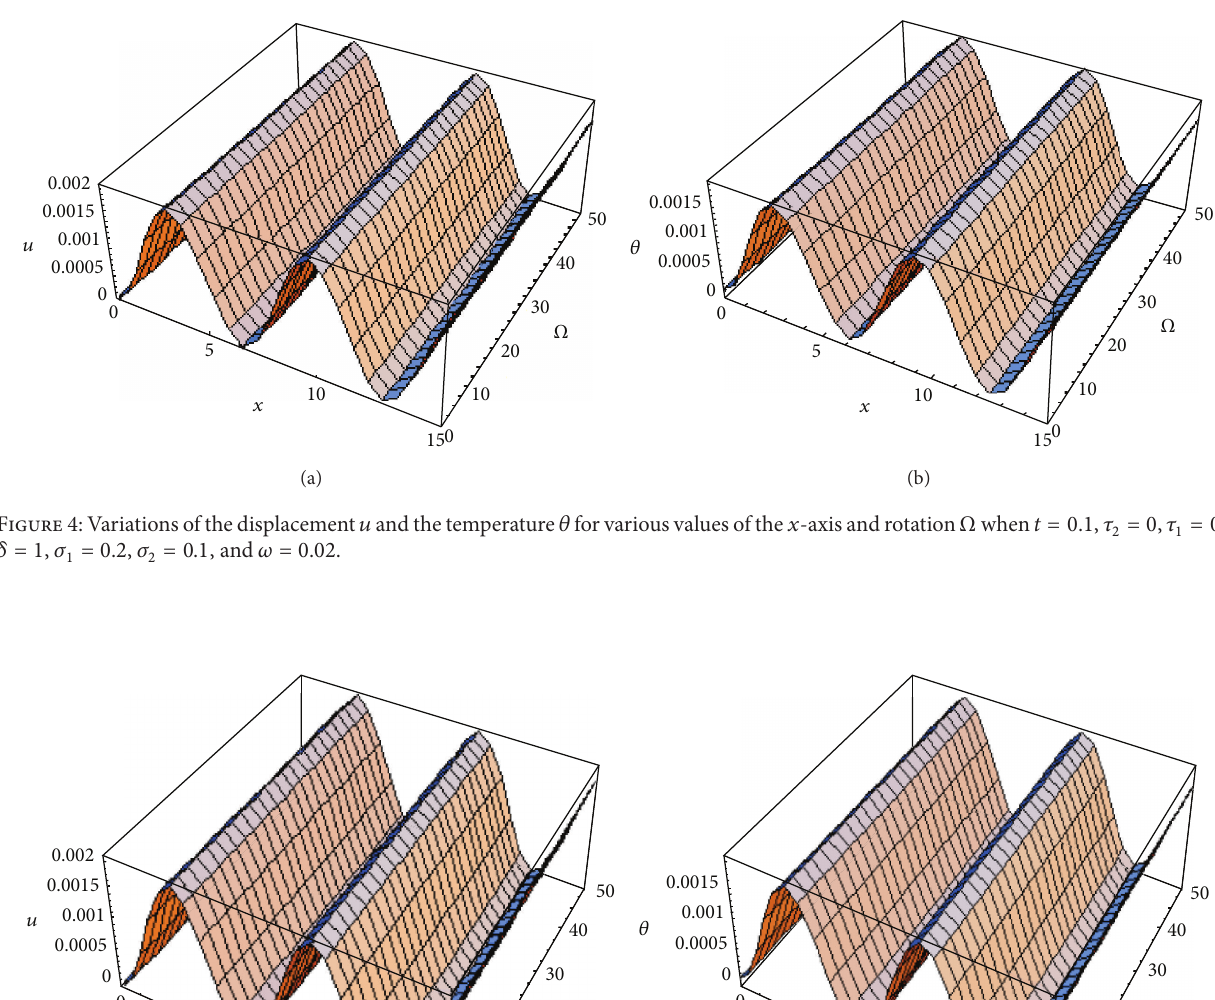
corresponding values in the absence of 𝜎 1 , 𝜎 2 , and Ω , but there is a slight change for LS and GL